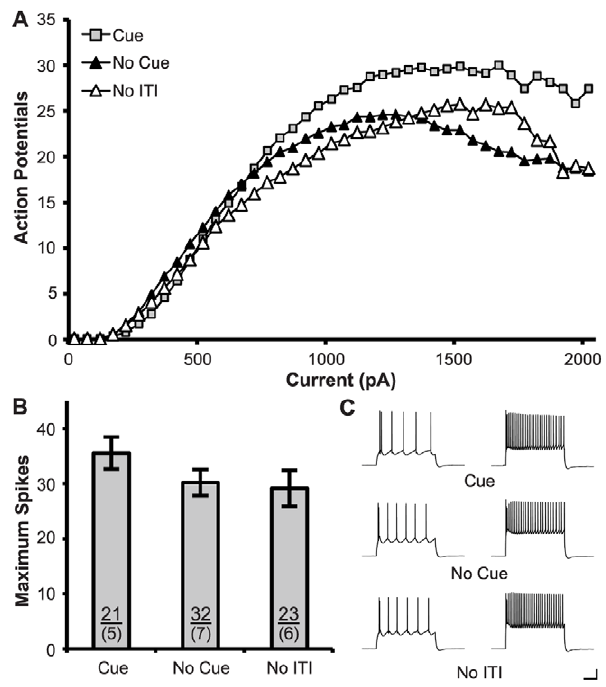
Figure 7. Training in the Cue condition had no effect on the intrinsic excitability of prelimbic neurons. A. Action potentials were produced by increasing current steps (800 ms, 50 pA steps). B. Learning the cue had no effect the maximum number of action potentials evoked. Sample sizes for subjects (above) and cells (below) are indicated within the bars. C. Representative traces show action potentials generated by 500 pA (left) and 1500 pA (right) current steps for differing behavioral conditions. (Calibration Bars: 20 mV/0.1 s; * : p , 0.05 vs. all groups).